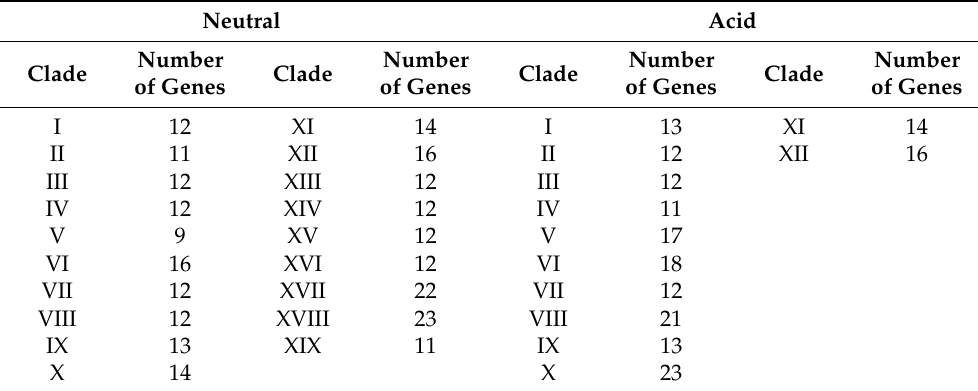
Table 2. The number of lipases in each clade of phylogenetic trees. Neutral Acid Clade Clade